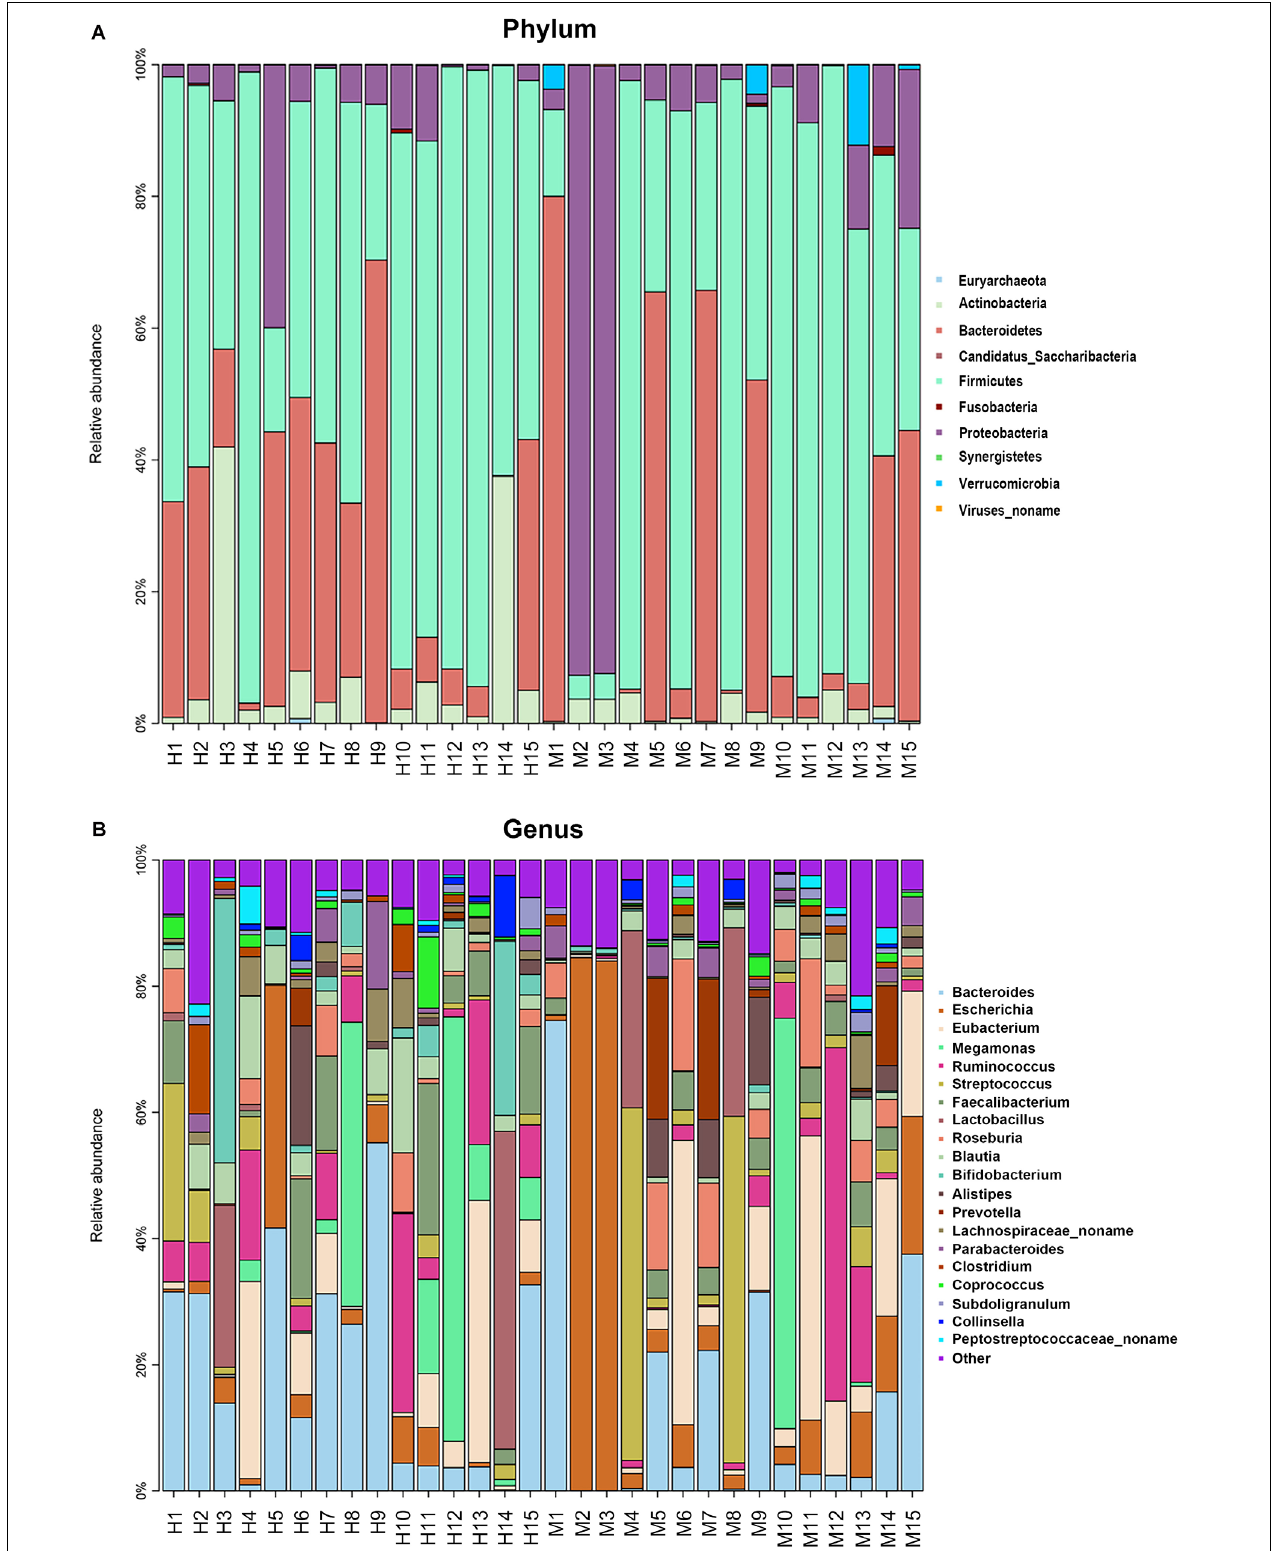
FIGURE 1 | The microbiota composition of each sample. Each bar represented different bacterial taxon and the length represented the relative abundance. (A) The relative abundance of top 10 taxa on phylum level. (B) The relative abundance of top 20 taxa on genus level. H, healthy group; M, MSA group.